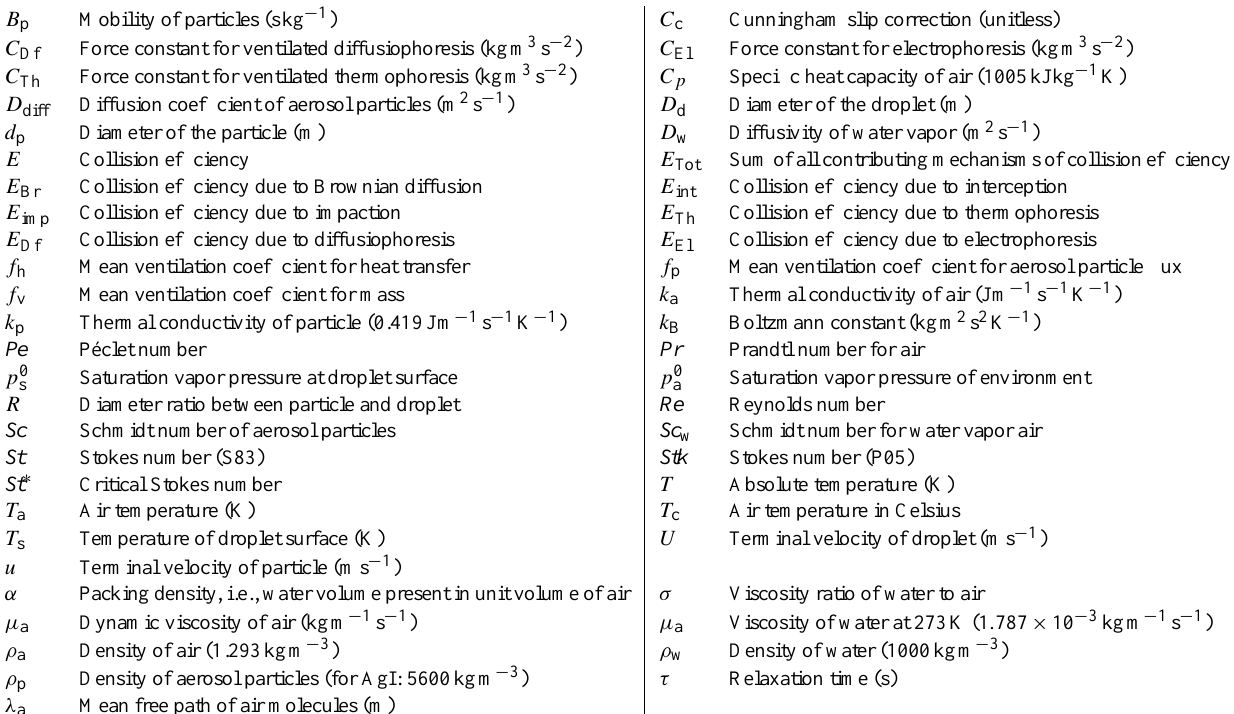
Table A1. List of